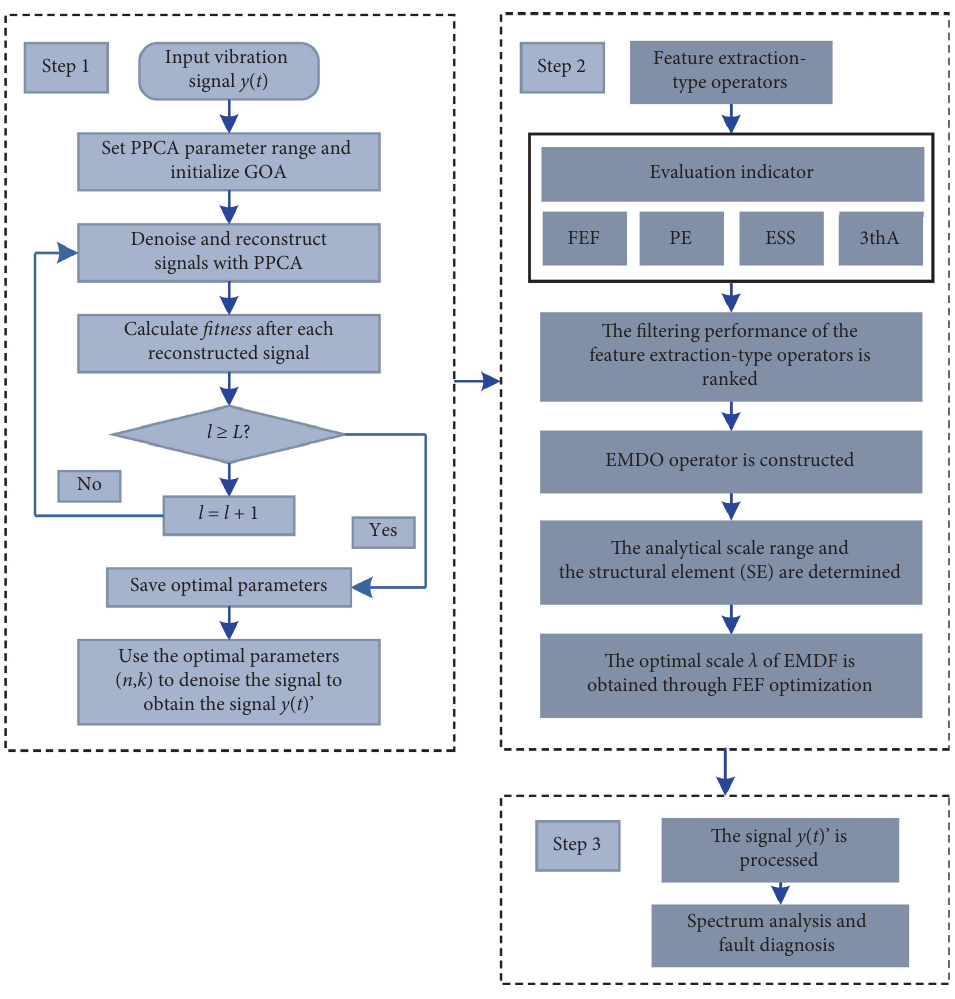
Figure 7: Flowchart of the proposed